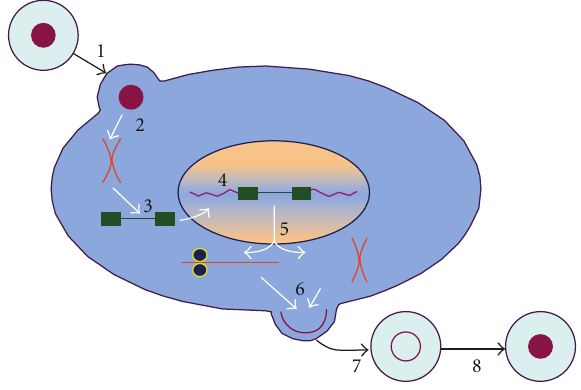
Figure 2: The orthoretroviral replication cycle. Infection is initiated when the mature, infectious virion binds to a receptor on the surface of the new host cell. The Env protein of the virus induces fusion between the viral membrane and the cell membrane (Step 1). Within the cytoplasm, the mature core dissociates (Step 2) and the dimeric viral RNA (shown in orange) is copied (Step 3) into double-stranded DNA (shown in green). The DNA copy enters the nucleus (probably when the nuclear membrane breaks down during mitosis) and is inserted into the chromosomal DNA of the cell (Step 4). The DNA is transcribed and the RNA product is exported from the nucleus (Step 5); within the cytoplasm, some molecules will be translated into viral proteins, and others are destined for encapsidation into progeny virus particles. The viral components assemble into budding virions (Step 6), which are released from the cell as immature particles (Step 7). Finally, PR cleaves the viral proteins, converting immature particles into mature, infectious virions (Step 8). It is possible that DNA synthesis actually occurs within the mature core rather than after dissociation of the core as shown